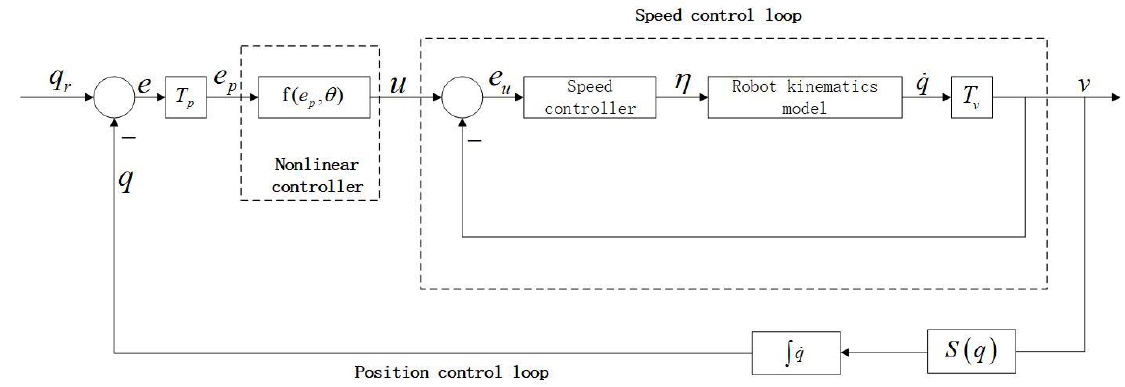
Figure 7. The feedback loop diagram of robot motion control.